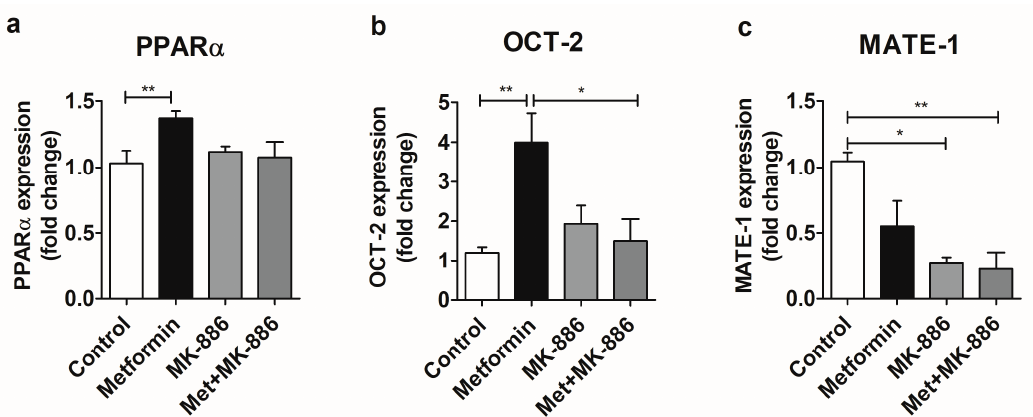
Figure 2. Modulation of PPAR alpha ( a ), OCT-2 ( b ), and MATE-1 ( c ) expression by metformin (50 µM). MK-886 was used at 25 µM. Cells were incubated for 24 h with the compounds. Data was compared by the nonparametric Kruskal-Wallis test, * p < 0.05, ** p < 0.01. Data is presented as Mean ± S.E.M. Met, metformin.